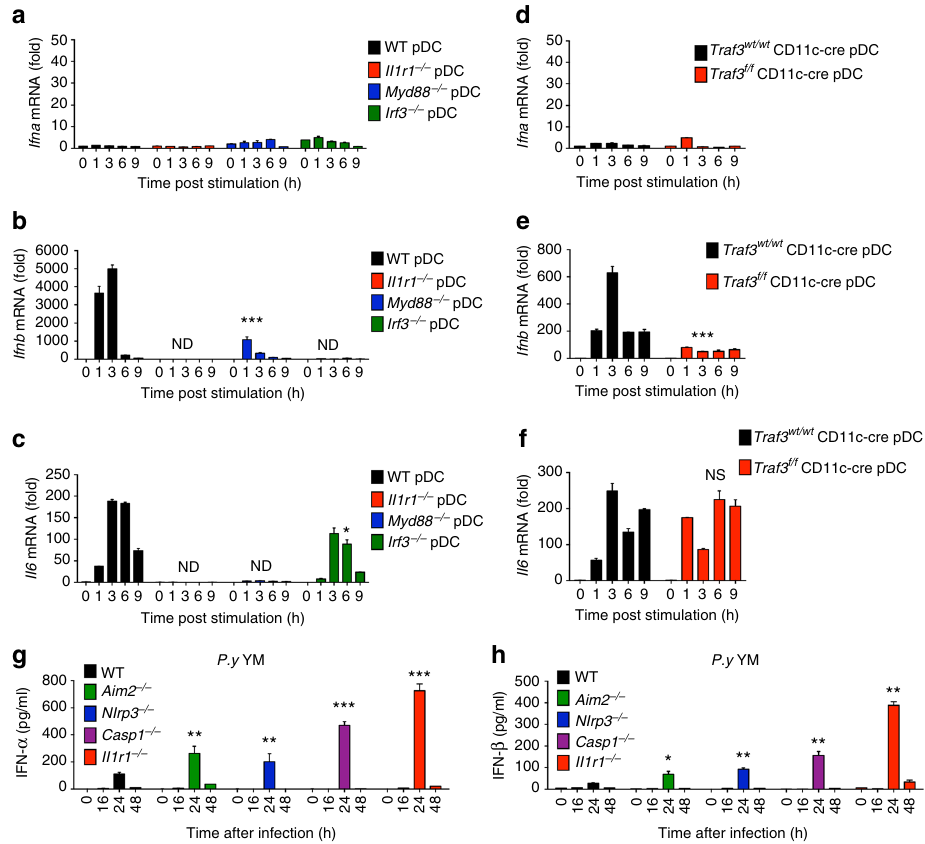
Fig. 3 IL-1 signaling activates MyD88-TRAF3-IRF3-dependent type I IFN signaling in vitro and negatively regulates type I IFN cytokine production in vivo. a – c WT, Il1r1 − / − , Myd88 − / − , and Irf3 − / − pDCs were stimulated with recombinant mouse IL-1 β for indicated times, and RNA from pDCs was isolated and used for expression analysis of Ifna ( a ) , Ifnb ( b ), and Il6 ( c ) by using qPCR. d – f Traf3 wt/wt CD11c-cre and Traf3 f/f CD11c-cre pDCs were stimulated with recombinant mouse IL-1 β for indicated times, and RNA from cells was isolated and used for expression analysis of Ifna ( d ) , Ifnb ( e ), and Il6 ( f ) by using qPCR. g , h WT, Aim2 − / − , Nlrp3 − / − , Casp1 − / − , and Il1r1 − / − mice were intraperitoneally infected with P. yoelii YM. Serum was collected at indicated times and subjected to ELISA analysis of IFN- α ( g ) and IFN- β ( h ). Data are representatives of three independent experiments with similar results and plotted as mean ± SD. * p < 0.05, ** p < 0.01, *** p < 0.001 vs. corresponding control. NS, not signi fi cant, ND, not